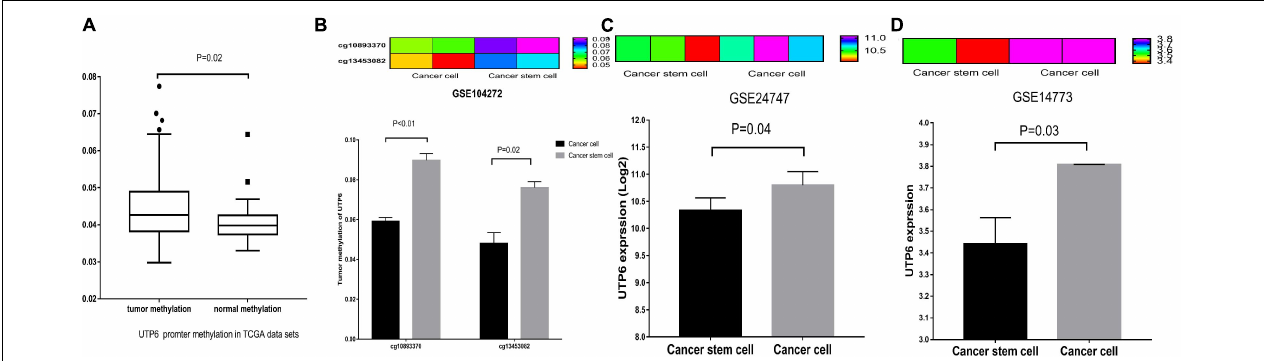
FIGURE 6 | UTP6 had increased promoter hypermethylation in colon tumors, lower expression in CRC stem cells. (A) From the TCGA database. UTP6 had increased promoter hypermethylation in colon cancer. (B) UTP6 had higher promoter methylation levels in cg10893370 and cg13453082 sites in CRC stem cells. Heat map and bar graph showed that CRC non-stem cells had higher UTP6 expression compared with CRC stem cells in GSE24747 (C) and GSE14773 (D) .